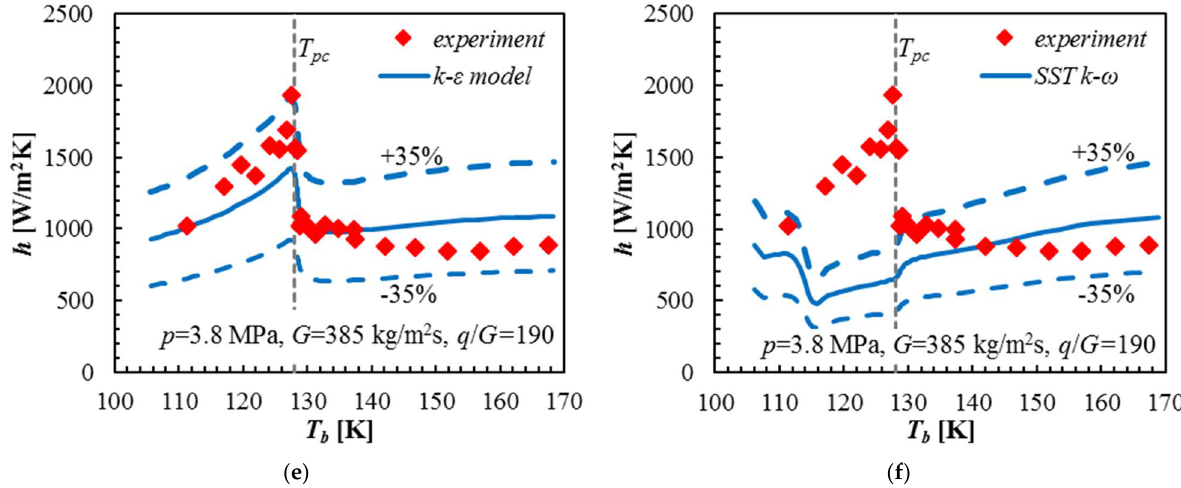
Figure 5. Comparisons of LHTCs between experimental results and simulation results with different turbulence models for various values of q / G (Unit: J/kg) at p = 3.8 MPa and T in = 101 K: ( a ) q / G = 78 with k - ε model; ( b ) q / G = 78 with SST k - ω model; ( c ) q / G = 135 with k - ε model; ( d ) q / G = 135 with SST k - ω model; ( e ) q / G = 190 with k - ε model; and ( f ) q / G = 190 with SST k - ω model. The blue dash lines represent ± 35% deviations with respect to the blue solid line (i.e., simulation results).